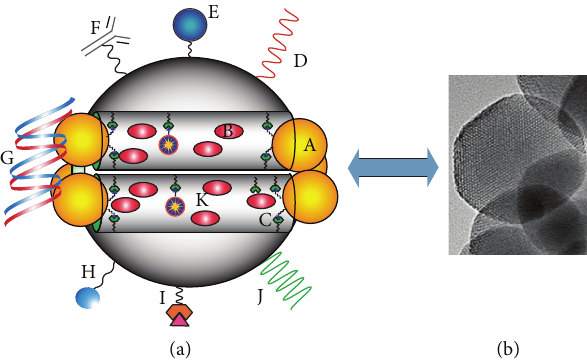
Figure 4: Schematic representation of MSNs as a platform for drug delivery (a). (A) Nanoparticles attached to MSNs as functional gate- keepers. (B) Hydrophobic/hydrophilic guest molecules entrapped in the interior of the nanochannels. (C) Stimuli-responsive linkers, which chemically attach MSNs and gatekeepers. (D) Grafting with a protecting polymer, such as PEG, shields the MSN surface from interacting with opsonizing proteins. (E) Bioimaging agents such as magnetic nanoparticles, quantum dots, or fluorophores. (F) Targeting ligands such as antibodies. (G) Complexation with plasmid DNA. (H) Additional ligands such as cell penetrating pep- tides. (I) Incorporation of a diagnostic label. (J) Stimuli-responsive polymers. (K) Attachment of functional groups that could modify the metabolism of cells. Transmission electron microscopy image of MSNs (b)